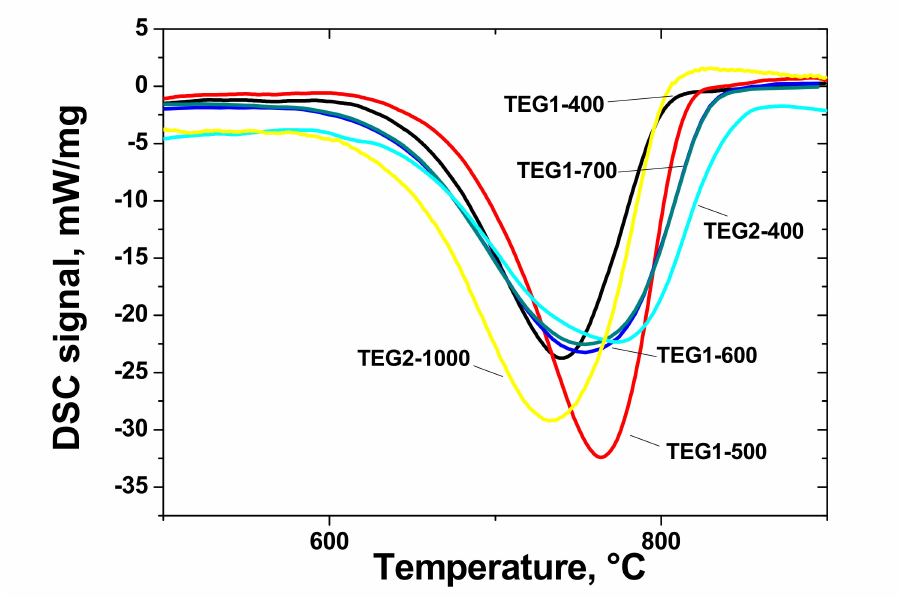
Figure 11. DSC curves of EG samples (10 K/min) (exo